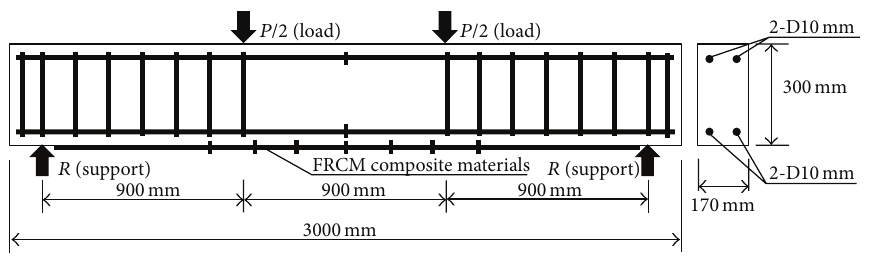
Figure 1: Test specimen layout.